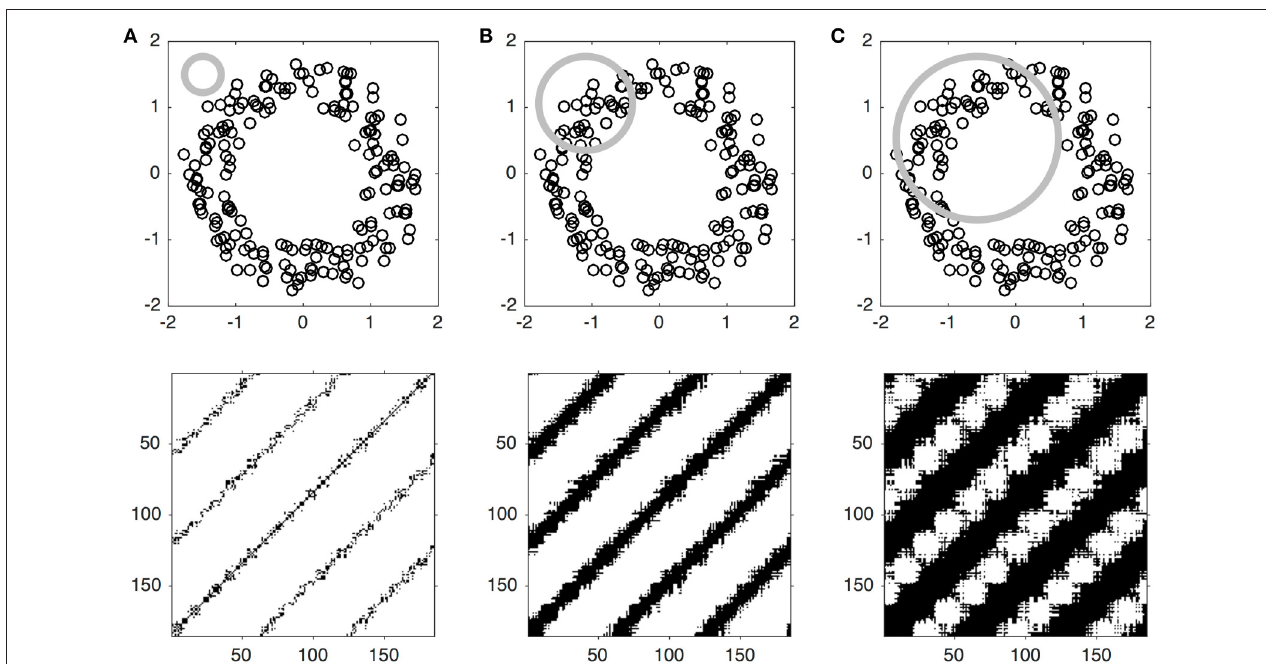
FIGURE 2 | Illustration of the effect of the threshold parameter on the percentage of recurrence points in an RP. The upper panels (A–C) show the same phase-spaces as in Figure 1 , but with an application of increasingly larger threshold, within which points in phase-space are counted as being recurrent, illustrated by a gray circle. The lower panels (A–C) show that the corresponding RP yield increasingly higher percentages of recurrence points, evident by the increasing thickness of the diagonal line patterns on the